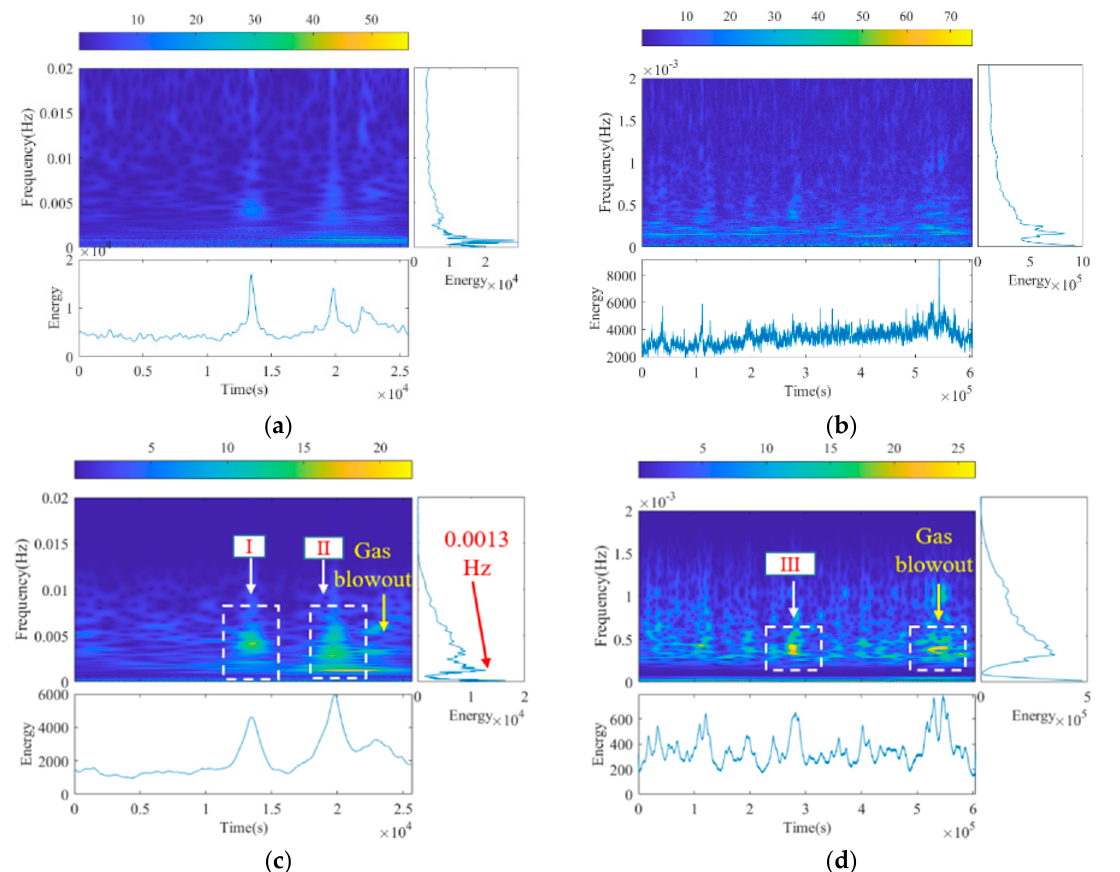
Figure 13. Time-frequency plane of danger signals. ( a ) Reconstructed AE signal based on d 1 – d 6 components. ( b ) Reconstructed EMR signal based on d 1 – d 8 components. ( c ) Reconstructed AE signal based on d 3 – d 5 components. ( d ) Reconstructed EMR signal based on d 6 – d 7 components.